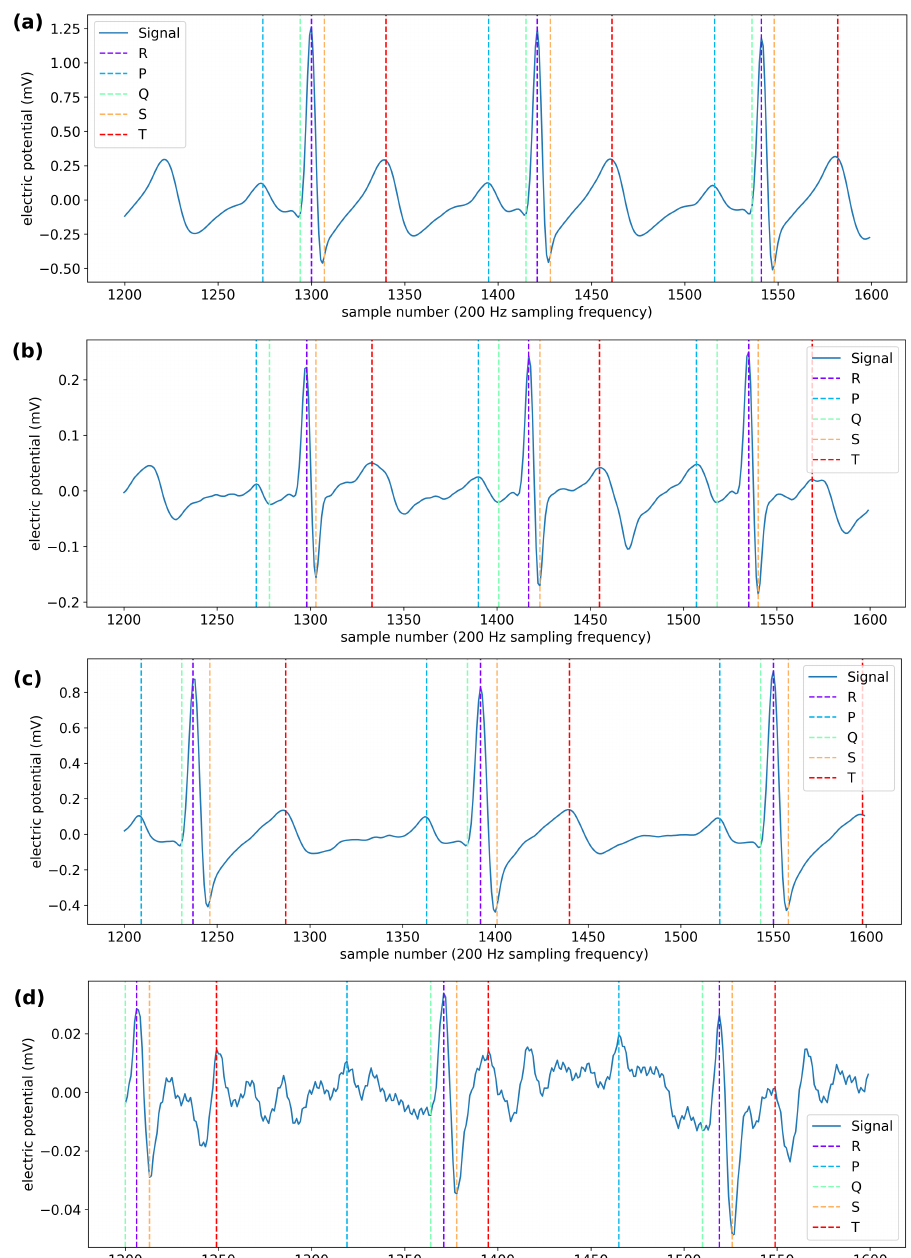
Figure 6. Each plot shows the ECG signal with each peak marked. ( a ) Signal from participant 9 using the adhesive electrodes. ( b ) Signal from participant 9 using the size 6 woven electrodes; the full ECG signal is not corrupted with noise, and most of the peaks are correctly detected. ( c ) Signal from participant 10 using the adhesive electrodes. ( d ) Signal from participant 10 using the same size 6 woven electrodes; the signal from participant 10 contains more high frequency noise and more large-scale noise features. Given the relatively clean adhesive signals for both participants, this suggests variability in the interaction between each individual and the woven electrode